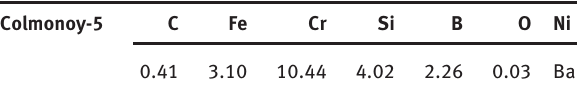
Table 2: Chemical composition (wt %) of hardfaced powder. Colmonoy- 